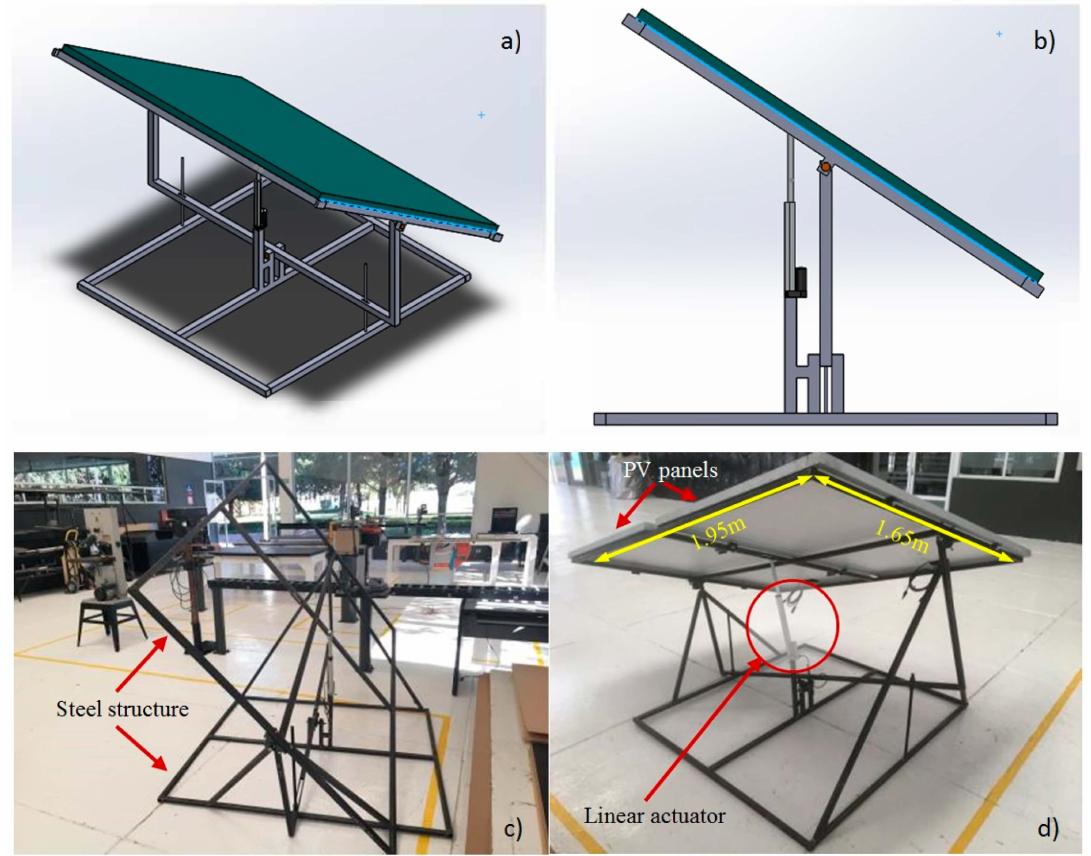
Figure 4. Isometric ( a ) and side ( b ) views of the support structure. Steel structure ( c ) and structure with photovoltaic (PV) panels ( d